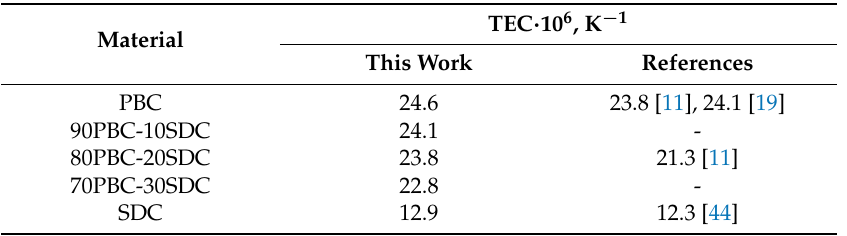
Table 1. The average TEC values of SDC electrolyte and (100 − y )PBC- y SDC ( y = 0–30 wt.%) cathode materials in the temperature range 30–1000 °C in air.